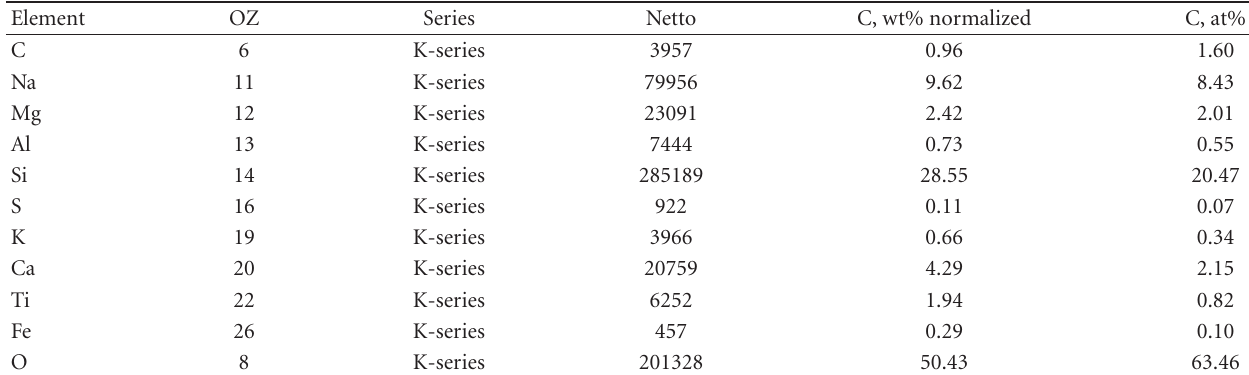
Figure 3: (a) SEM image of the TiO 2 :(Fe, S) sample 72. (b) SEM image of the TiO 2 :(Fe, S) sample 74. Table 3: Quantitative results of the EDX analysis of TiO 2 :(Fe, S), sample 72.